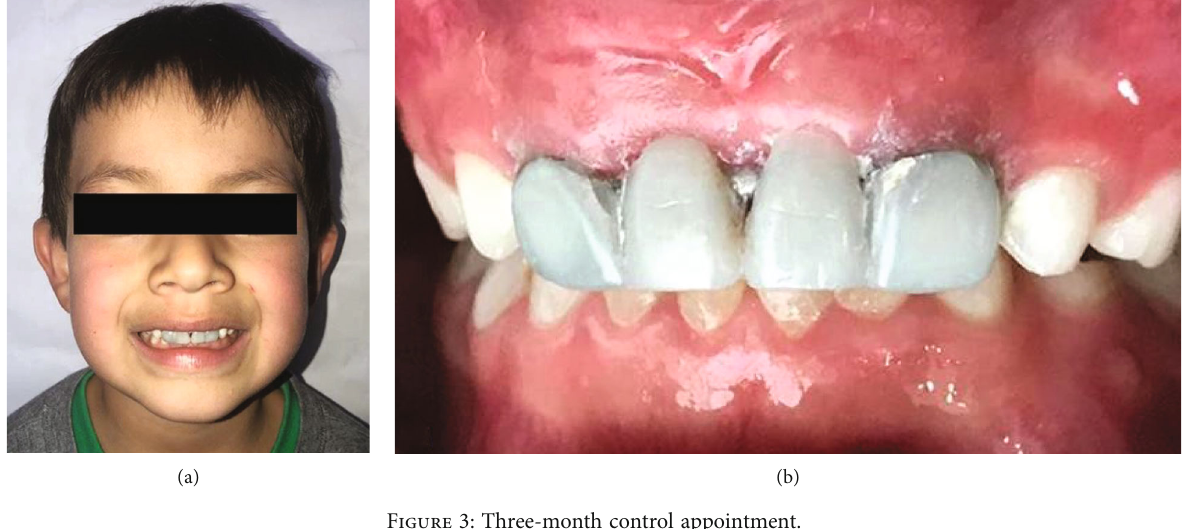
Figure 3: Three-month control appointment.